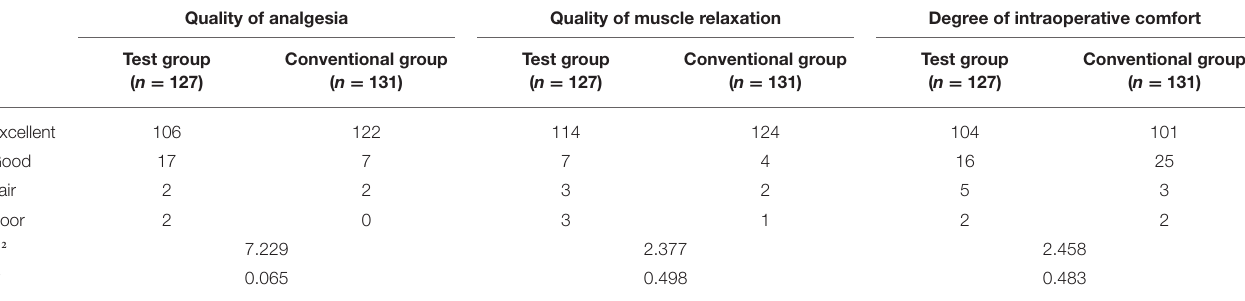
TABLE 6 | Quality of anesthesia.